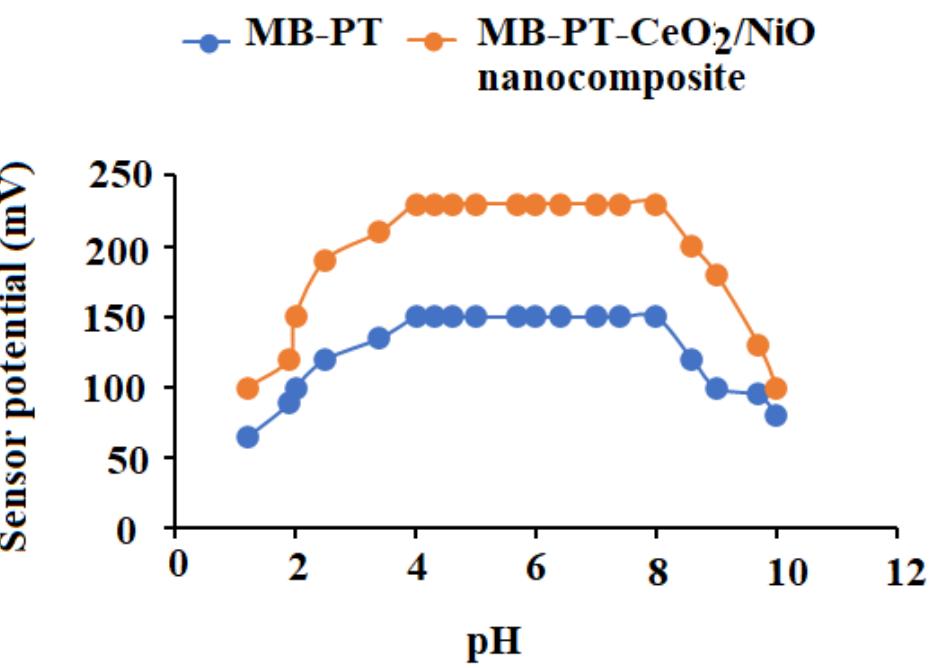
Figure 8. The suitable and independent pH range of the designed sensors MB-PT and MB-PT-